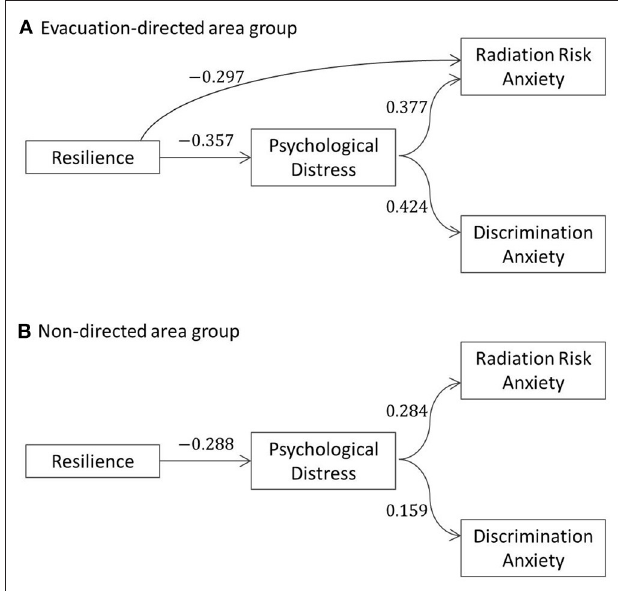
FIGURE 2 | Mediation model from resilience to radiation risk and discrimination anxiety via psychological distress. (A) Evacuation-directed area group. (B) Non–directed area group. Path coefficients are standardized regression coefficients; only statistically significant paths are